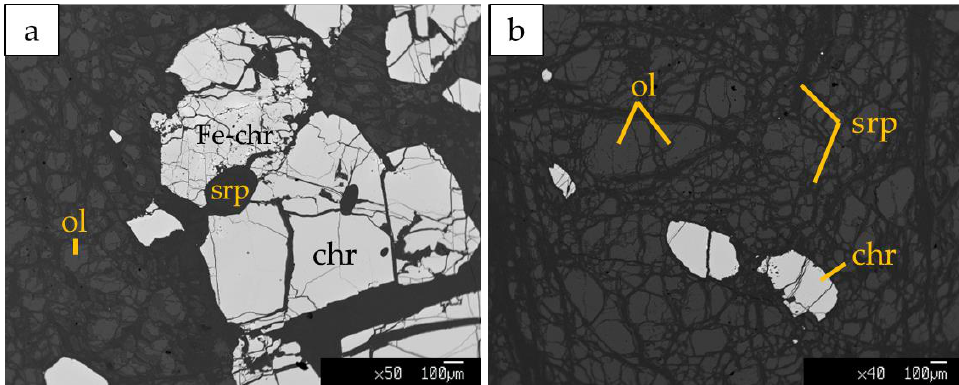
Figure 5. BSE images of ( a ) densely disseminated chromitites at Kymasi; ( b ) Dunite with accessory spinel in contact with chromitites. Fe-chr: ferrian chromite, ol: olivine, chr: chromite, srp: serpentine.